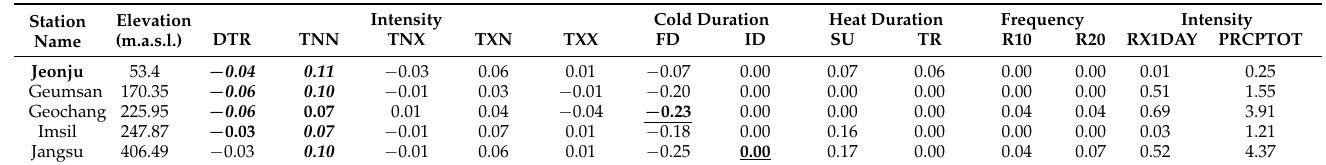
Table A5. Trend magnitudes during autumn season (SON) in the UGRB for 33 years (1988–2020). Station Name